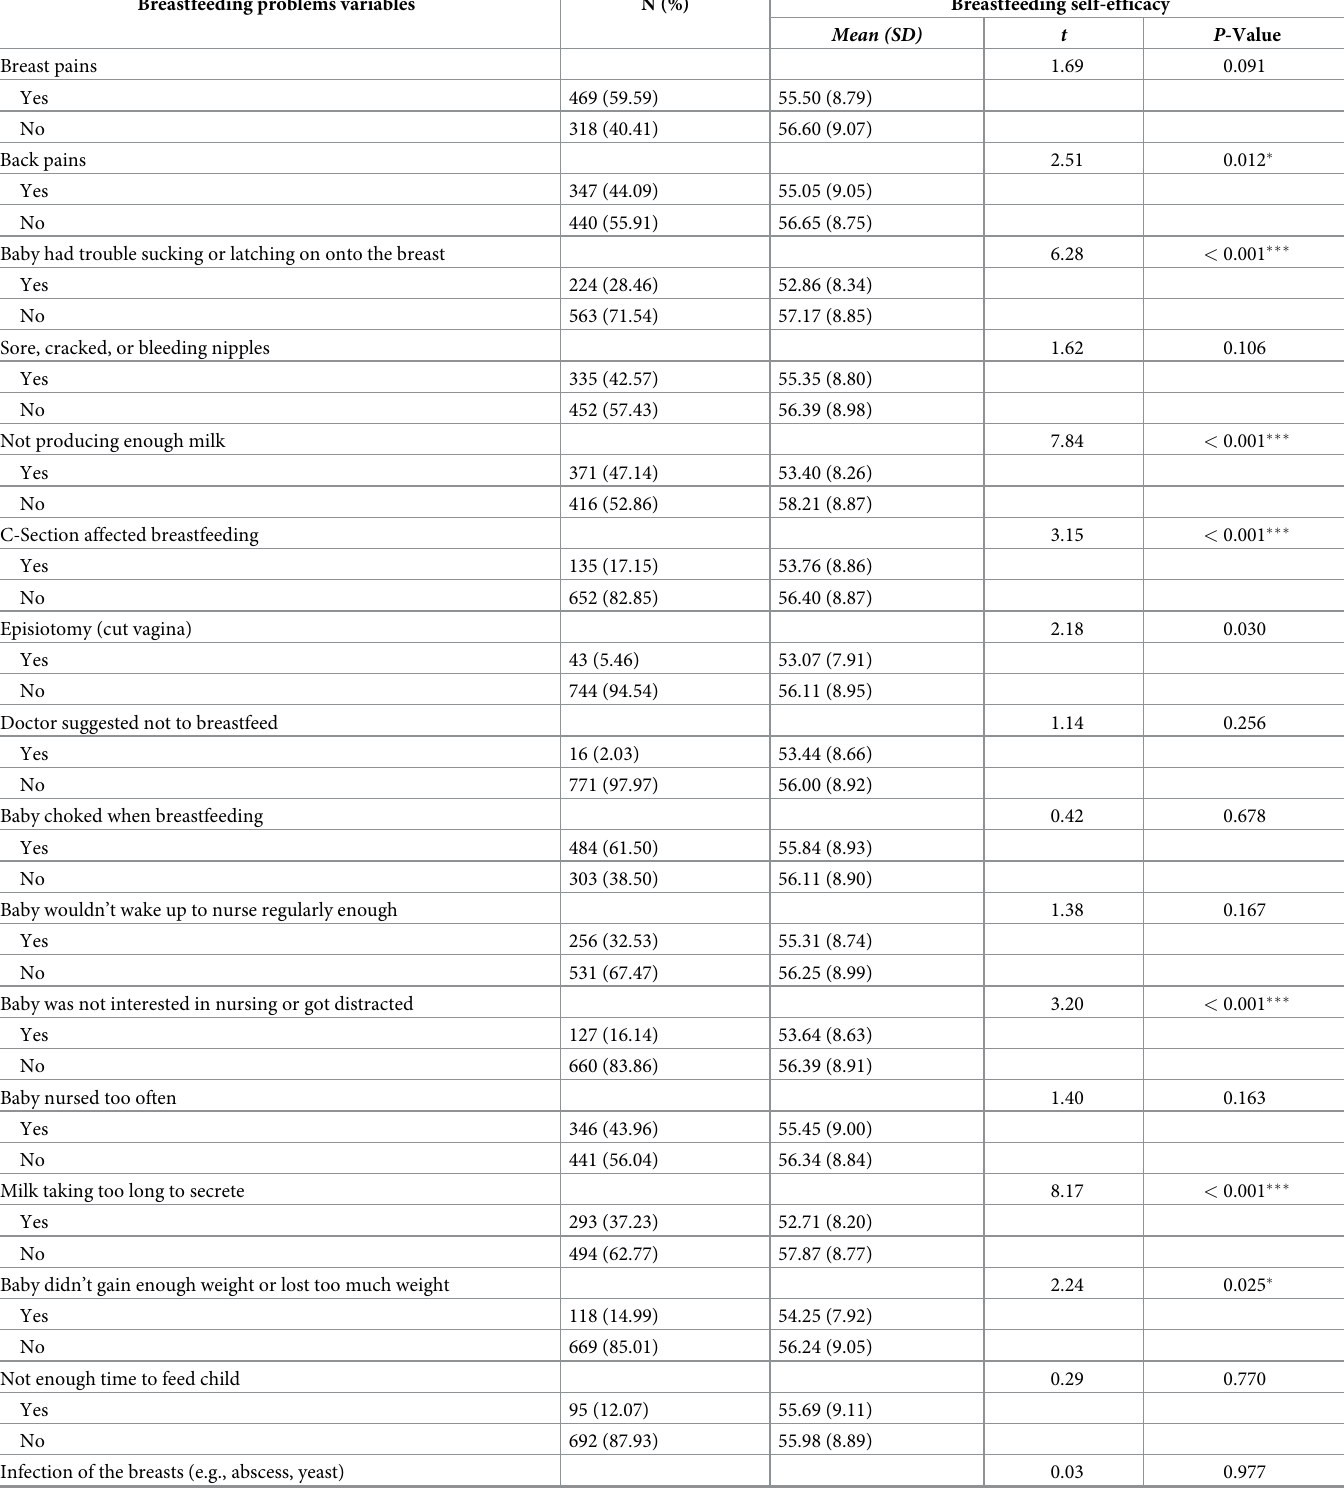
Table 4. Descriptive statistics of breastfeeding problems and univariate analysis with breastfeeding self-efficacy (N = 787). Breastfeeding problems